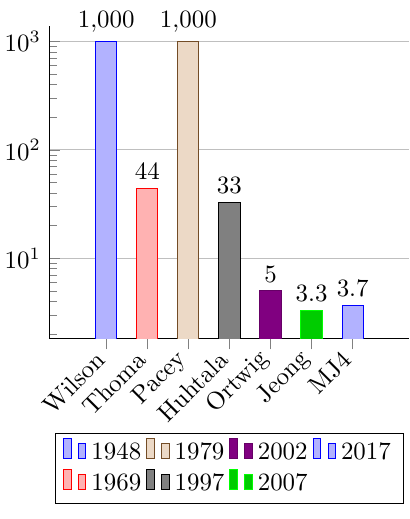
Figure 3: Model error, when optimizing model param- eters for fixed displacement. Displacement